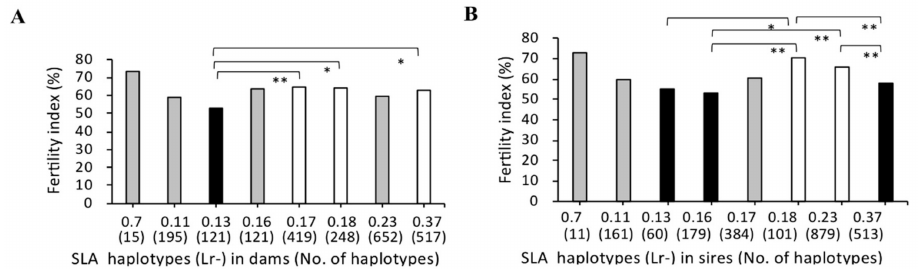
Figure 1. Comparison of the fertility indices of microminipigs (MMP) with different swine leukocyte antigen (SLA) class II haplotypes. X -axis shows the haplotypes of homozygous or heterozygous dams ( A ) and sires ( B ) and number of matings for each haplotype in brackets (no. of haplotypes). The Y -axis shows the fertility index as indicated by the ratio (%) of the number of deliveries to the number of matings, expressed as the mean value (bar). The number of haplotypes was counted as two in homozygous individuals. Black and white bars represent lower, and higher fertility indices, respectively, of the mean values, and the significant differences among haplotypes are indicated by the asterisks. Probabilities of significant differences among haplotypes are indicated by single ( p < 0.05) and double ( p < 0.01) asterisks. Gray bars represent mean values of fertility indices without significant differences among the haplotypes.